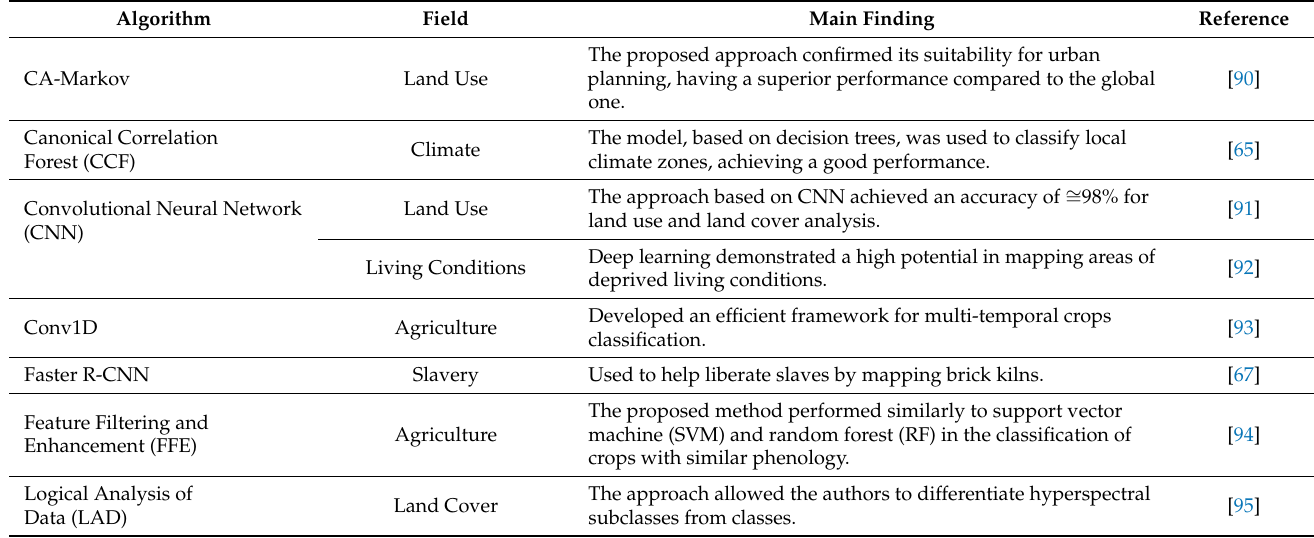
Table 1. Examples of classification algorithms using EO